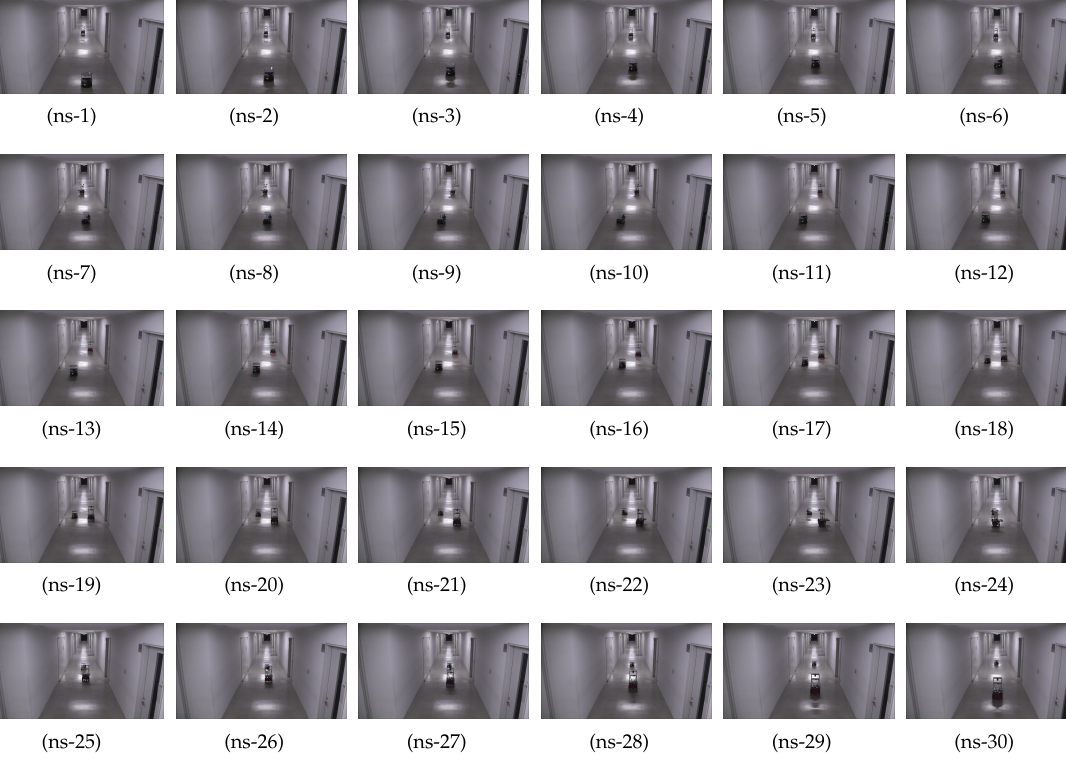
Figure 17. Timely snapshots of the non-smoothed navigation and collision avoidance. The robot actions at different steps are summarized in Table 6. Please see the supplementary video. Table 6. Description of robot actions at different steps (non-smooth case of Figure 17). Figure Action Description Figure 17(ns-1) ∼ (ns-4) Move Straight Robots navigate towards each other Figure 17(ns-5) Stop Both the robots stop upon threshold distance Figure 17(ns-6) ∼ (ns-9) Move Left Robots move left to ≈ 127 cm of the wall Figure 17(ns-10) ∼ (ns-12) Stop and Turn Right Robots turn right Figure 17(ns-13) ∼ (ns-20) Crossover Robots cross each other Figure 17(ns-21) Stop Robots stop to make a turn again Figure 17(ns-22) ∼ (ns-25) Approach Center and Turn Robots navigate to center of corridor and turn Figure 17(ns-26) ∼ (ns-30) Move Straight Robots continue towards their